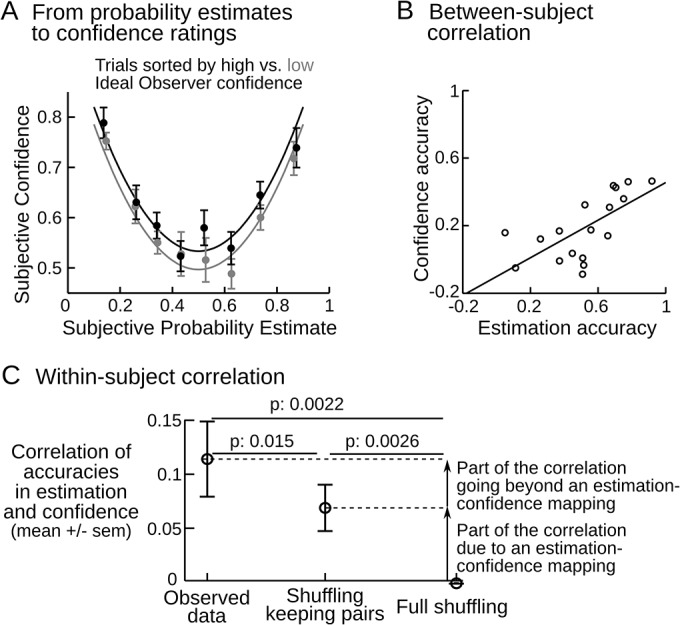
Evidence that probability estimates and confidence derive from a single process.
(A) Subjective confidence is higher for extreme estimates of transition probabilities. The fitted lines correspond to the average of the quadratic fits performed at the subject level: confidence ~ constant + (probability estimate-0.5)2. Trials were sorted by subjective probability estimates and, within each bin, into high and low Ideal Observer confidence according to a median split. Equally-filled bins were used for data visualization, not for data analysis. (B) The accuracies of probability estimates and confidence ratings are correlated across subjects. The accuracy of probability estimates was computed per subject as the correlation (across trials) of the subject's and the Ideal Observer's estimates. The same logic was used for confidence. One dot corresponds to one subject. (C) The link between probability estimates and confidence ratings goes beyond any mapping. Within each subject, we computed the correlation across trials between accuracies in probability estimates and confidence ratings. The accuracy of probability estimates was computed at the trial level as the distance between the subject's and the Ideal Observer's estimates. The same logic was used for confidence. The observed results are contrasted to two ways of shuffling the data (p-values are from one-tailed t-test, see Methods).